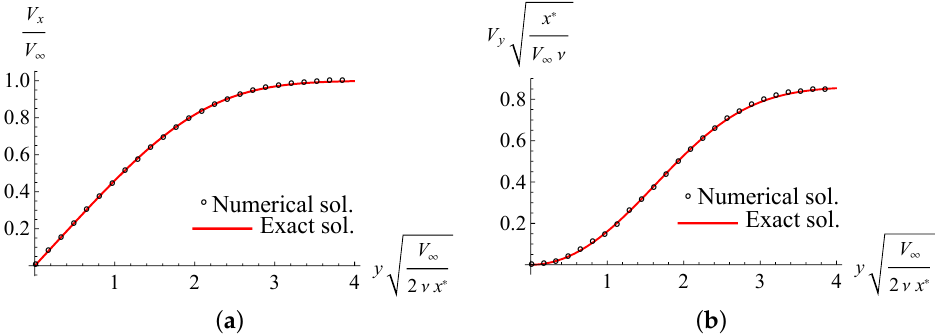
Figure 4. Horizontal ( a ) and vertical ( b ) velocity profiles for the Blasius flow in the cross-section distant at one-forth from the leading tip (black circles) and the analytical solution (red solid